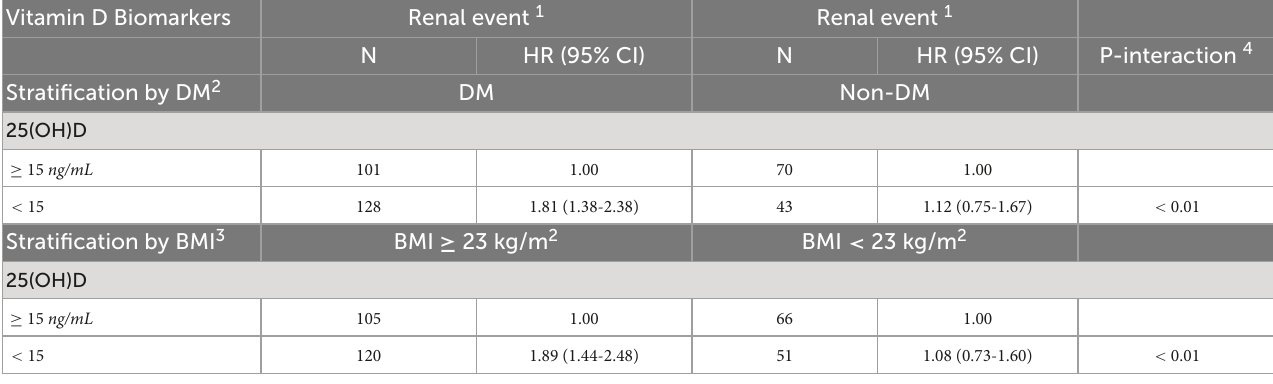
TABLE 4 Association between serum vitamin D levels and renal event according to diabetes and overweight status in the Korean Cohort Study for Outcome in Patients With Chronic Kidney Disease (KNOW-CKD) study, 2011-2015. Vitamin D Biomarkers Renal event